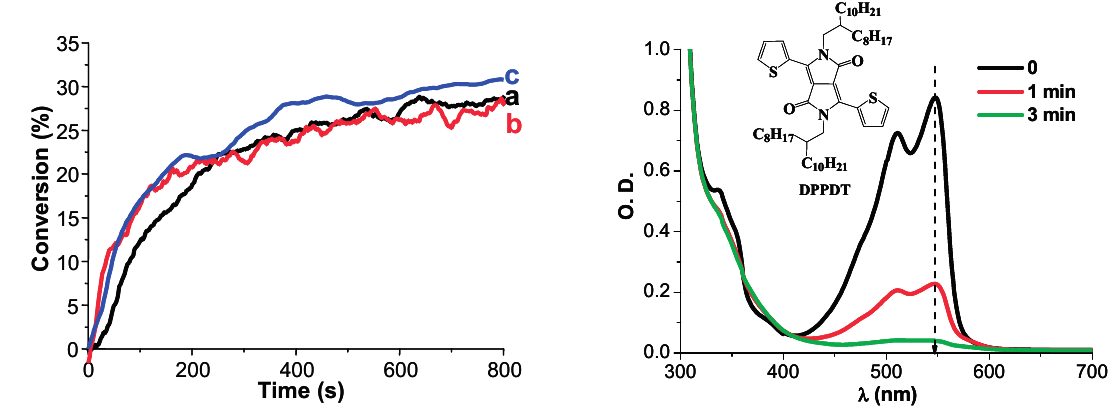
Figure 1. ( A ) UV-visible absorption spectra of ND10 and ND4; ( B ) Photopolymerization profiles for EPOX under air in the presence of (i) ND4/Iod/NVK (0.5%/2%/3%, w / w / w ) upon the laser diode at 457 nm (curve 1) exposure; and (ii) ND10/Iod/NVK (0.5%/2%/3%, w / w / w ) upon the laser diode at 457 nm exposure (curve 2) [105].